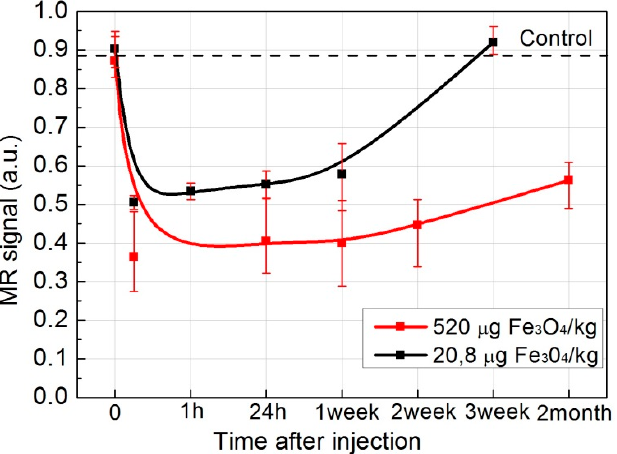
Figure 6. Relative MR signal intensity at the injection site versus time at the different doses of Fe 3 O 4 (red curve—520 µg Fe 3 O 4 /kg, black—20.8 µg Fe 3 O 4 /kg).